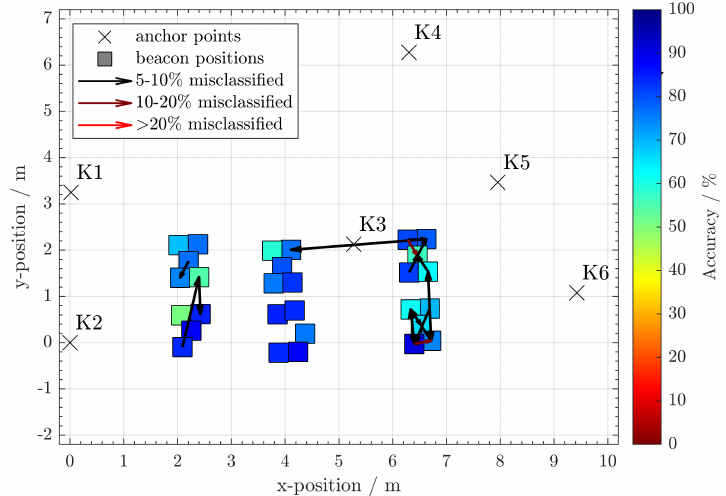
Figure 20. Approximate positions of the clustered beacon positions and the most clear misclassifications using a neural network . The colors of the beacon clusters indicate their accuracy of correct